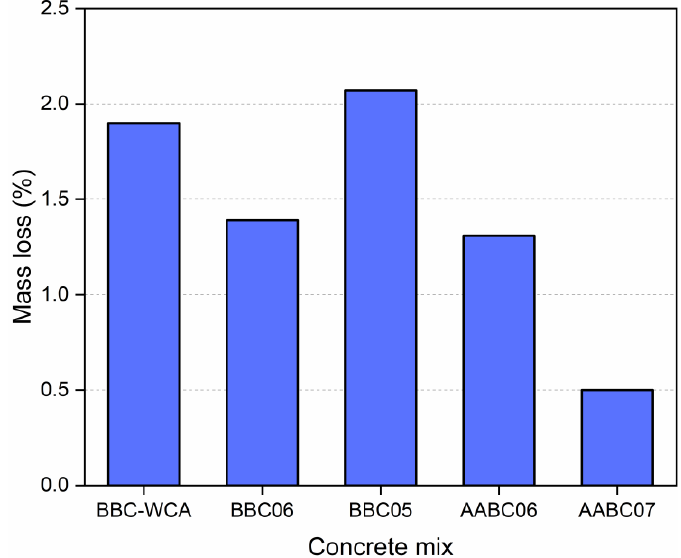
Figure 15 . Mass loss after in-depth abrasion test for each mixture. Figure 15. Mass loss after in-depth abrasion test for each